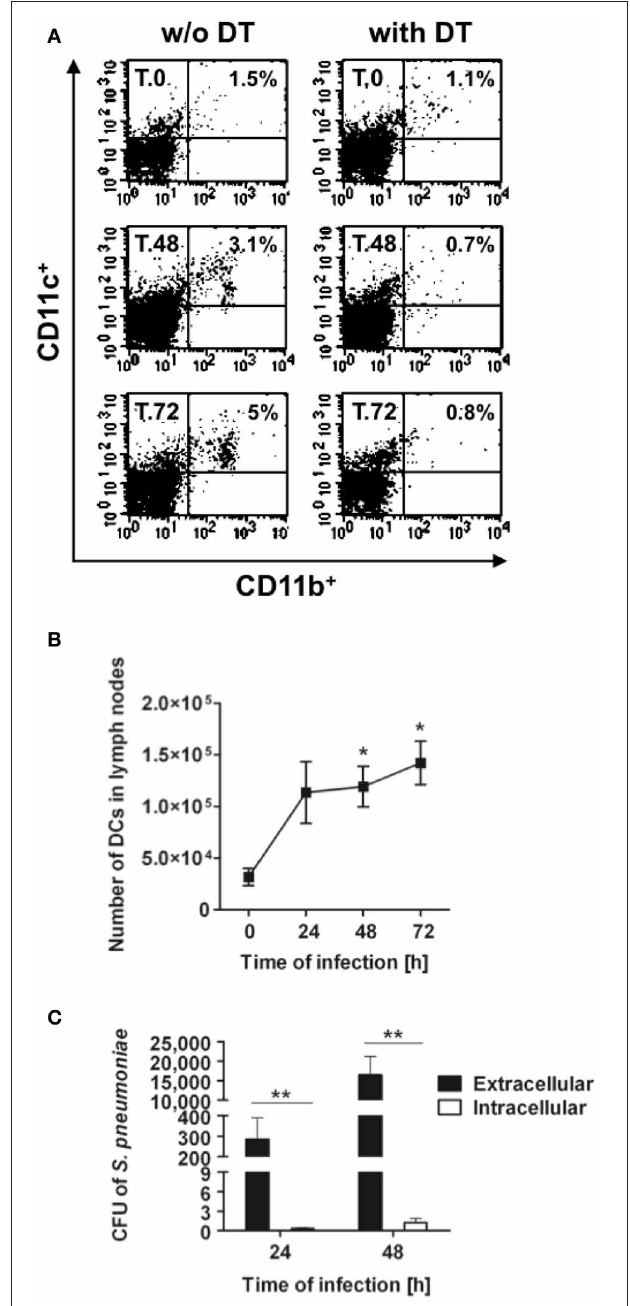
FIGURE 6 | Trafficking of DCs to the mediastinal lymph nodes after intranasal infection with S. pneumoniae . DCs-depleted and non-depletedCD11c-DTR chimera mice were intranasally infected with 1 × 10 8 CFU of S. pneumoniae , the mediastinal lymph nodes were removed before (0h) and at 24, 48, and 72h after bacterial inoculation and transformed in a single cell suspension. Cells were then counted, stained with anti-mouse CD11c and anti-mouse CD11b antibodies and analyzed by flow cytometry. (A) Representative dot plots of DCs in the mediastinal lymph nodes of S. pneumoniae -infectedDCs-depleted (right histograms) and non-depleted(left histograms) mice. The numbers in each dot plot represent the percentageof DCs. One representativeexperimentout of (Continued)